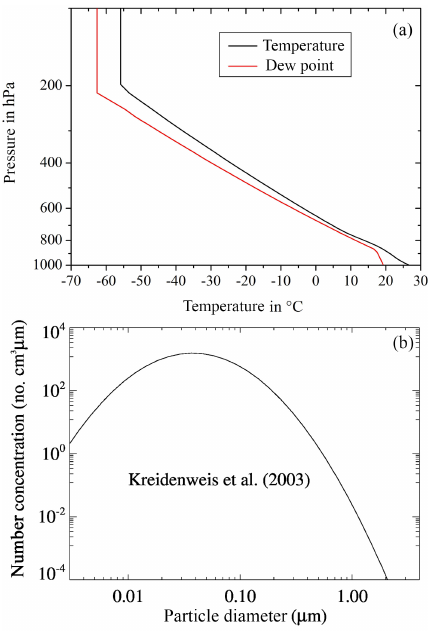
Figure 2. Initial conditions of model simulations. (a) Verti- cal profiles of temperature and dew point from Weisman and Klemp (1982). (b) Initial dry particle number size distribution ac- cording to Kreidenweis et al.